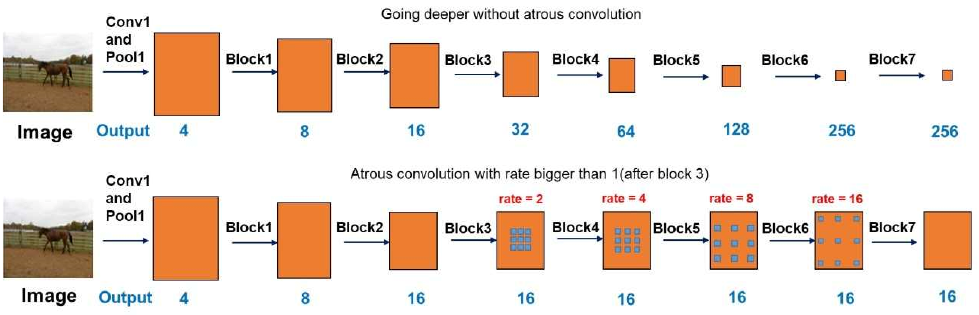
Figure 1. Cascaded modules without and with atrous convolution